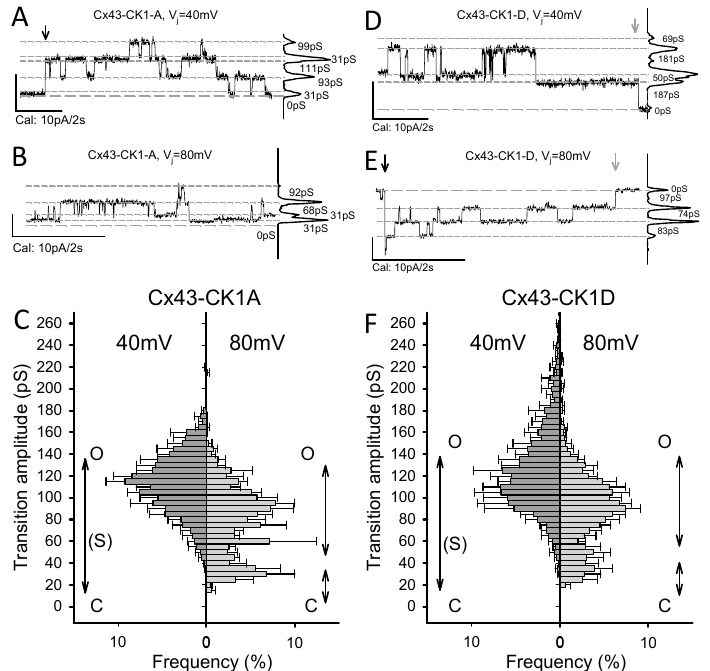
Figure 2. Cx43-CK1-A and Cx43-CK1-D display fully open, V j -sensitive gap junction channels. ( A , B , D , E ) Illustrative traces of channel activity from Cx43-CK1-A ( A , B ) and Cx43-CK1-D ( D , E ) expressing cell pairs, at 40 mV ( A , D ) and 80 mV ( B , E ) transjunctional gradients. For all traces: zero current (long-dashed line) and the most evident I j levels (short-dashed lines) are indicated; when present, downward arrows mark the beginning (black) and end (gray) of pulses; plots at right are the all-points histogram for the displayed record segment, showing the fraction of time at each I j level; numbers indicate the conductance change between current levels. Notice that channel transitions often occur between the identified levels. ( C , F ) Average transition amplitude histograms at 40 and 80 mV V j values from Cx43-CK1-A ( C ) and Cx43-CK1-D ( F ). Peak fits indicated by solid black lines. Likely transitions between channel states (see main text for further explanation) are indicated by double arrowed vertical